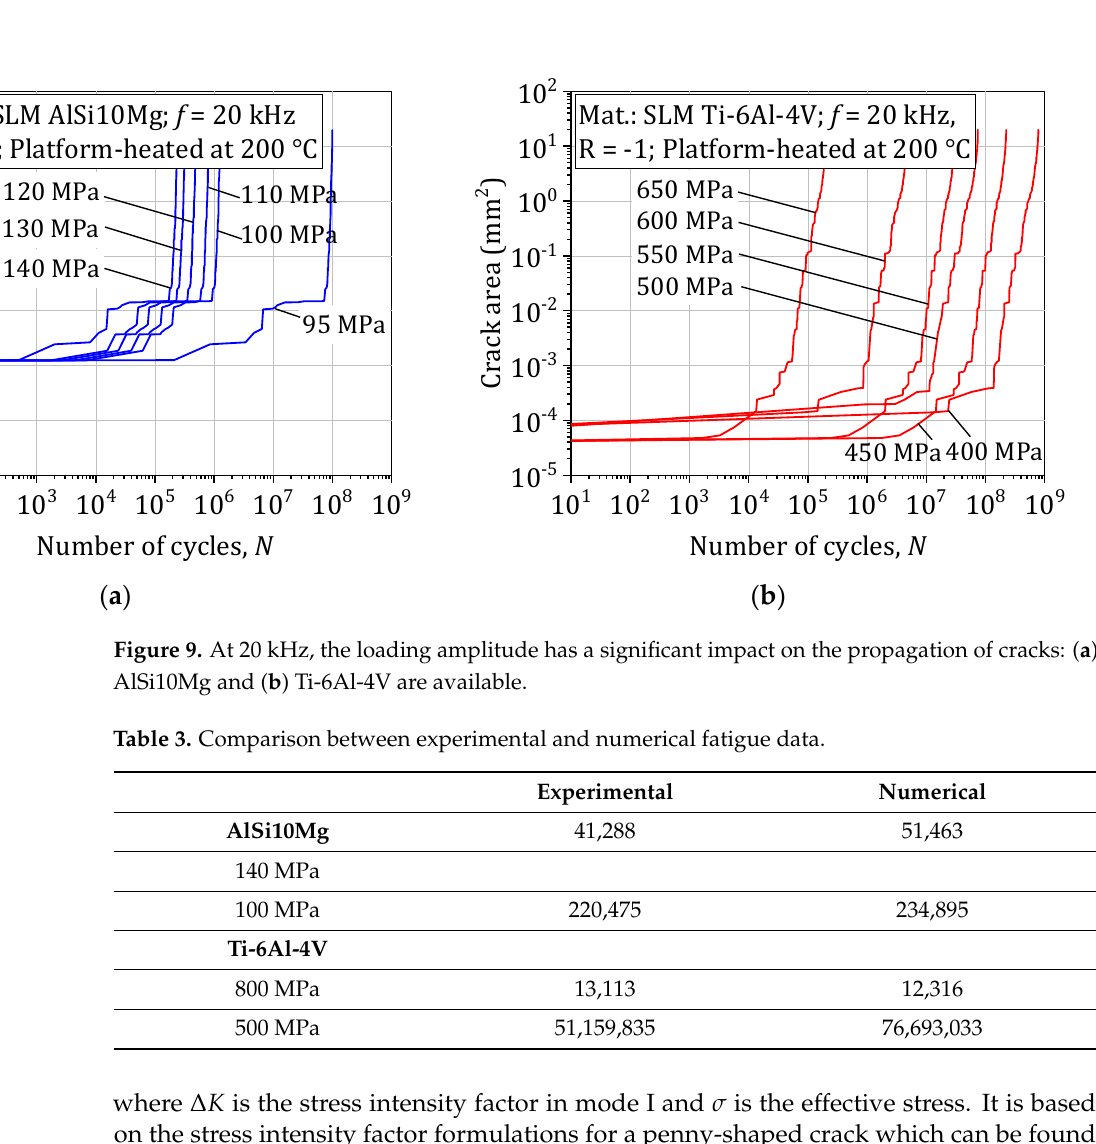
Figure 8. Influence of loading amplitude on the crack area evolution during low-frequency fatigue loading: ( a ) AlSi10Mg and ( b ) Ti-6Al-4V.